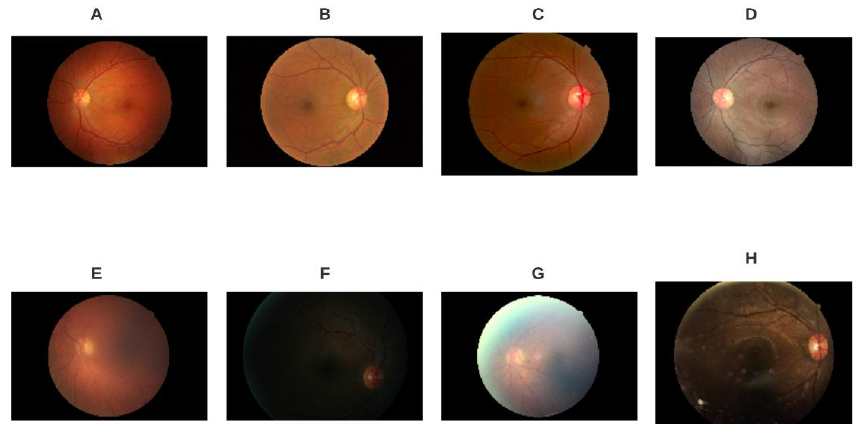
Figure 2. Examples of EyePACS images selected for the study with label good quality ( A , B , C , D ) and bad quality ( E , F , G , H ). Notice the variability within labels given by color, illumination, blurring, and anatomical landmarks.